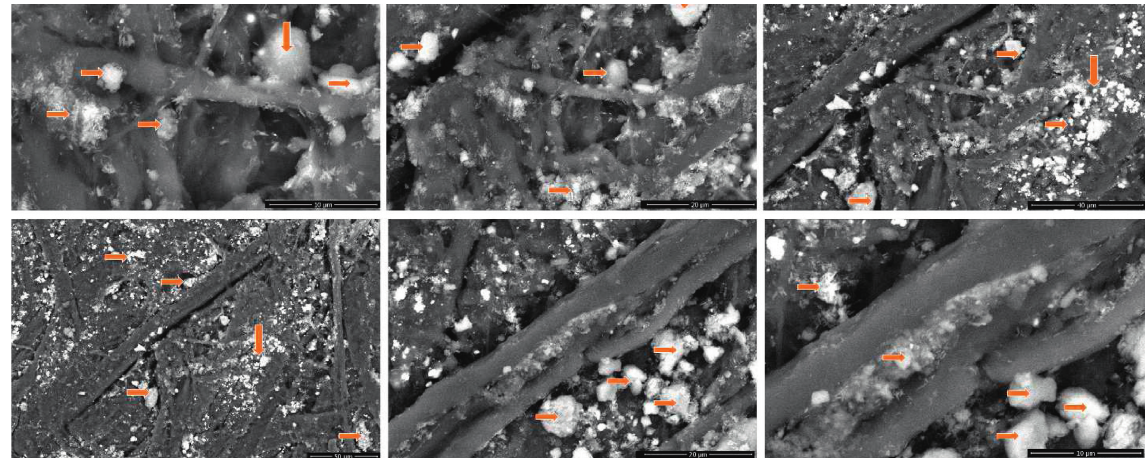
Figure 8: SEM images showing the distribution of barium sulfate (BaSO